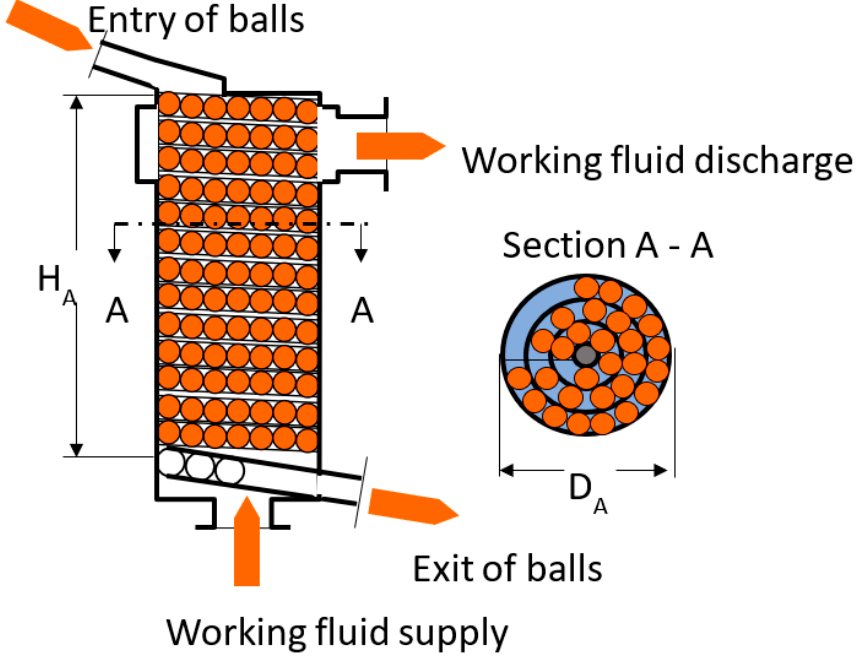
Figure 3. Ball circulating heat accumulator for solid heat storage devices [32]. Original drawing of Walter Lachenmeier during the initial patent development phase (kindly provided from the estate of Walter Lachenmeier with permission of the heirs).